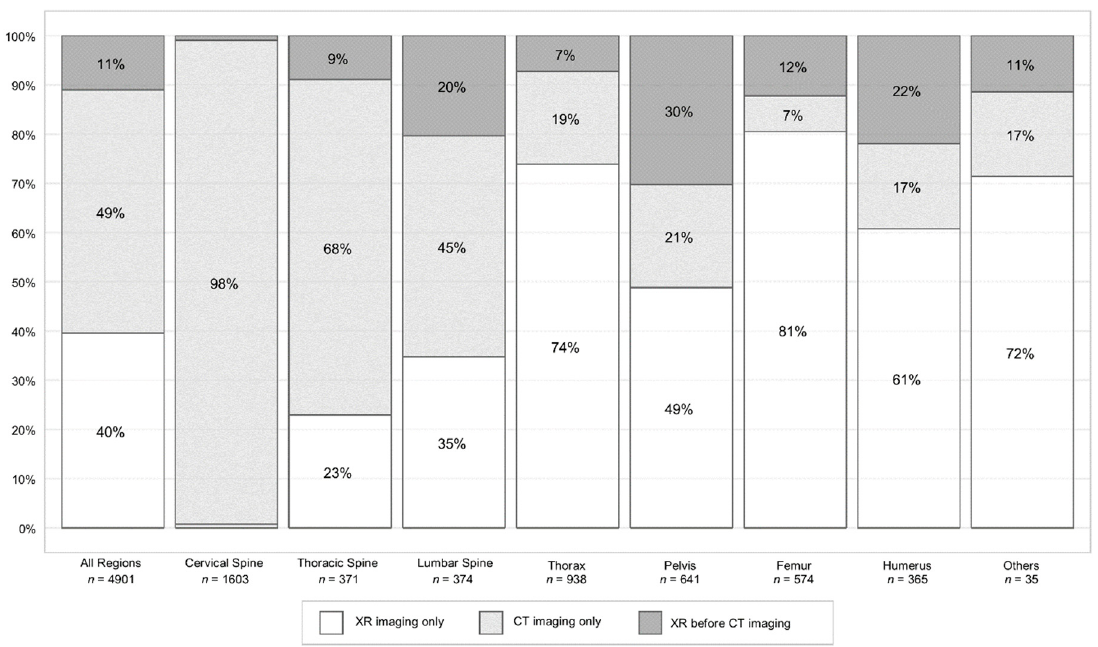
Figure 2. Proportion (%) of imaging work-flows “XR imaging only”, “CT imaging only”, and “XR before CT imaging” ( n = 4901 imaging processes) of the cervical spine, thoracic spine, lumbar spine, rib cage, pelvic ring, proximal femur and humerus, and other regions (clavicle, scapula, sternum, and coccyx). CT = computed tomography, XR = plain radiography.